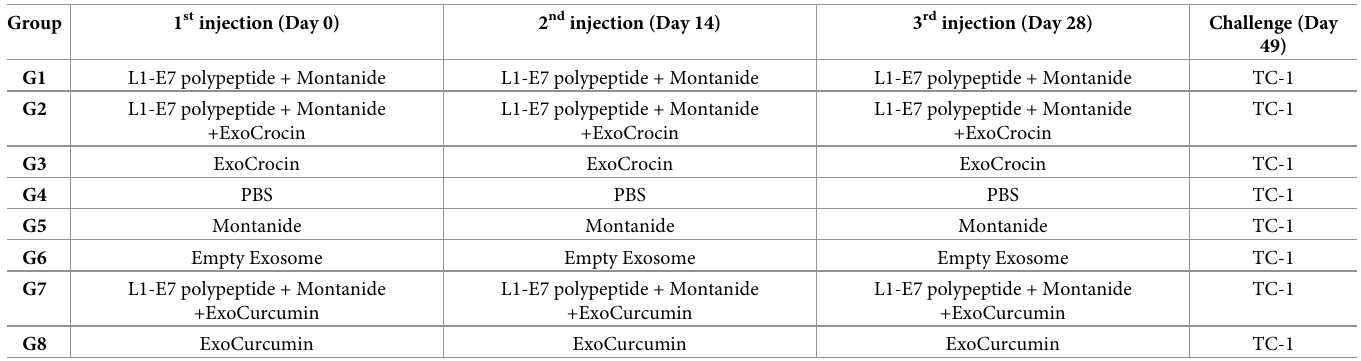
Table 1. Mice immunization for protective study.